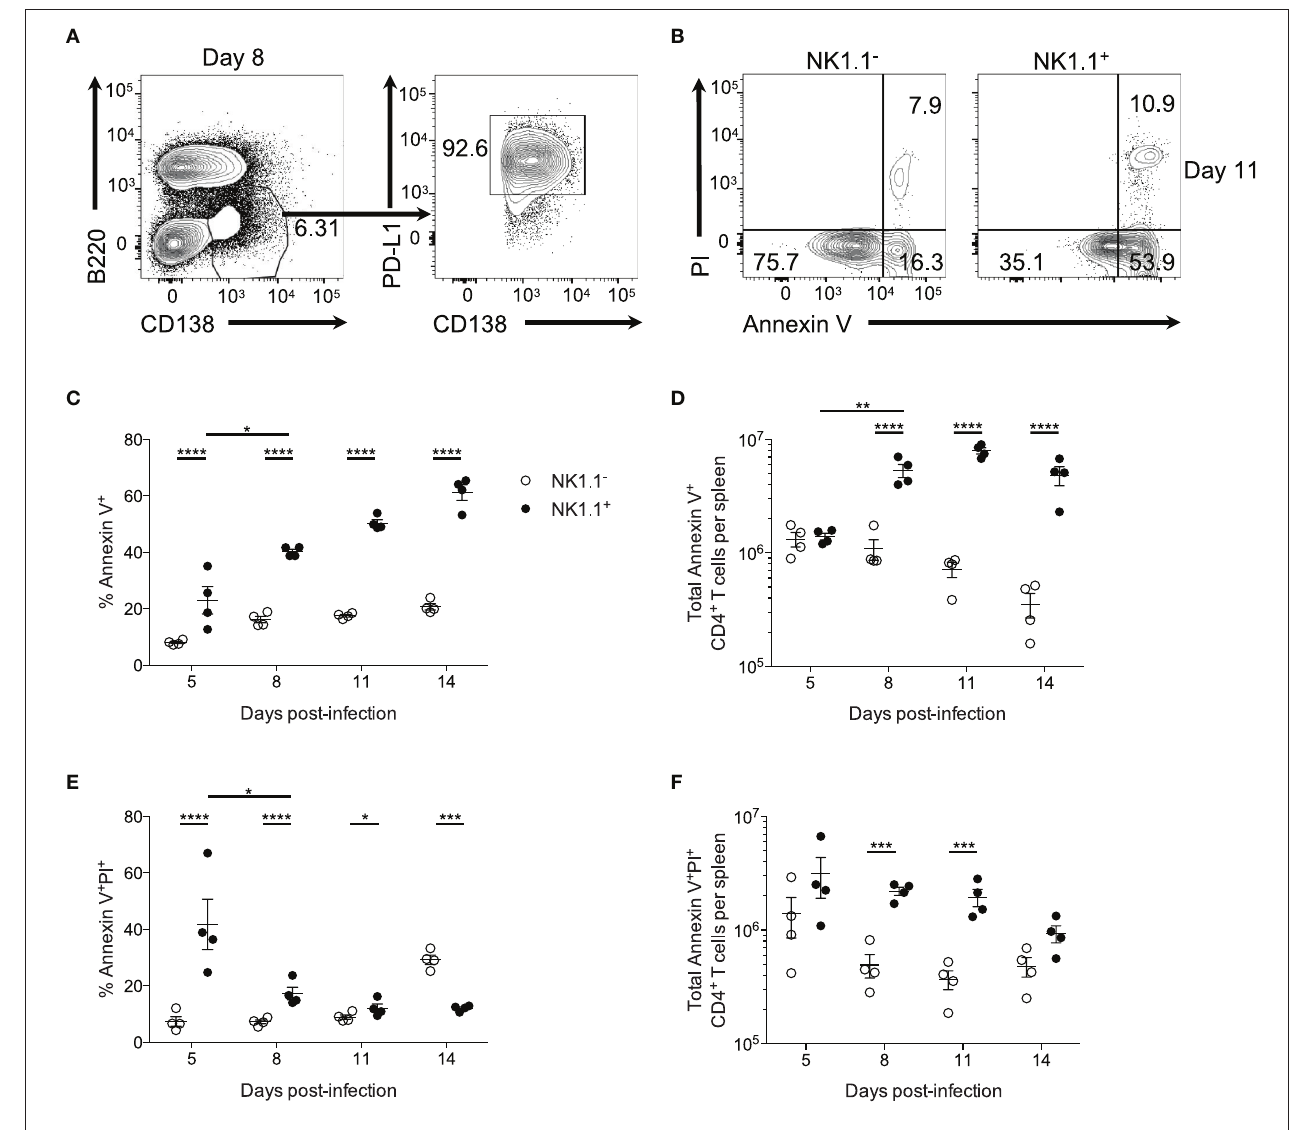
FIGURE 6 | NK1.1 + CD4 + T cells undergo accelerated apoptosis. (A) Representative B220 and CD138 expression at day 8 post-infection. PD-L1 and CD138 expression of gated area at left. (B) Typical PI and Annexin V staining of NK1.1 negative or positive CD4 + TCR β + T cells at day 11 post-infection. (C) Frequency and (D) the total number of Annexin V + NK1.1 negative or positive CD4 + T cells per spleen. (E) Frequency and (F) total number of Annexin V + PI + NK1.1 negative or positive CD4 + T cells per spleen. An aligned rank transformation was performed on non-parametric data before determining significance by two-way ANOVA with a post hoc Holm-Sidak’s multiple comparisons test. * p < 0.05, ** p < 0.01, *** p < 0.001, **** p < 0.0001. Data are representative of two independent experiments (error bars,